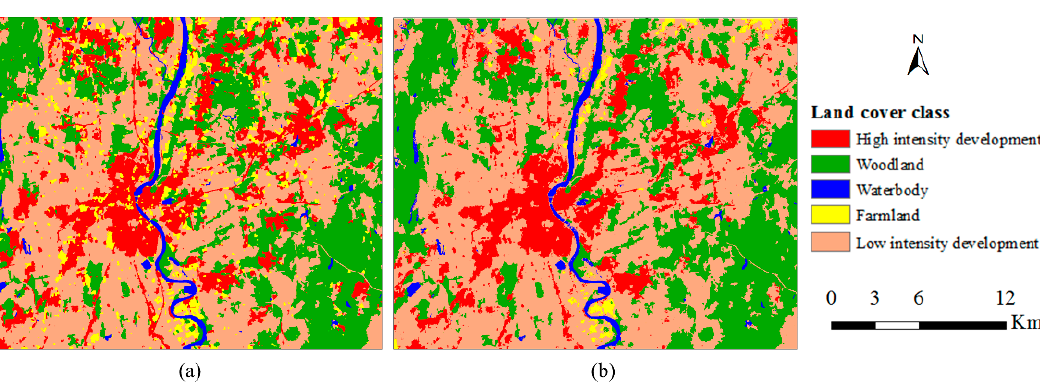
Figure 8. Land use/cover classification results for the Hartford study area: ( a ) pre-classification map; ( b ) MCRF post-classification.